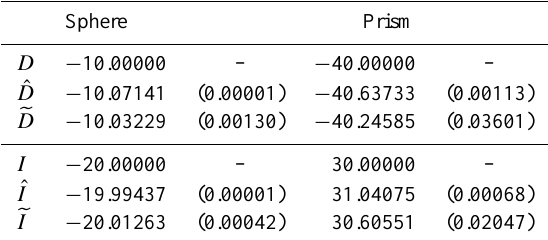
Table 1. Test with the synthetic data (Fig. 3a) produced by a sphere and a rectangular prism. Comparison between the estimated and true values of the magnetization declination D and inclination I . The uncertainties σ D and σ I (shown between parentheses) are cal- culated by using Eqs. (34) and (35). All values are in degrees ( ◦ ). We use a caret ( ∧ ) and a tilde ( ∼ ) to distinguish the quantities computed by using, respectively, the least-squares ˆ h and robust e h estimates.